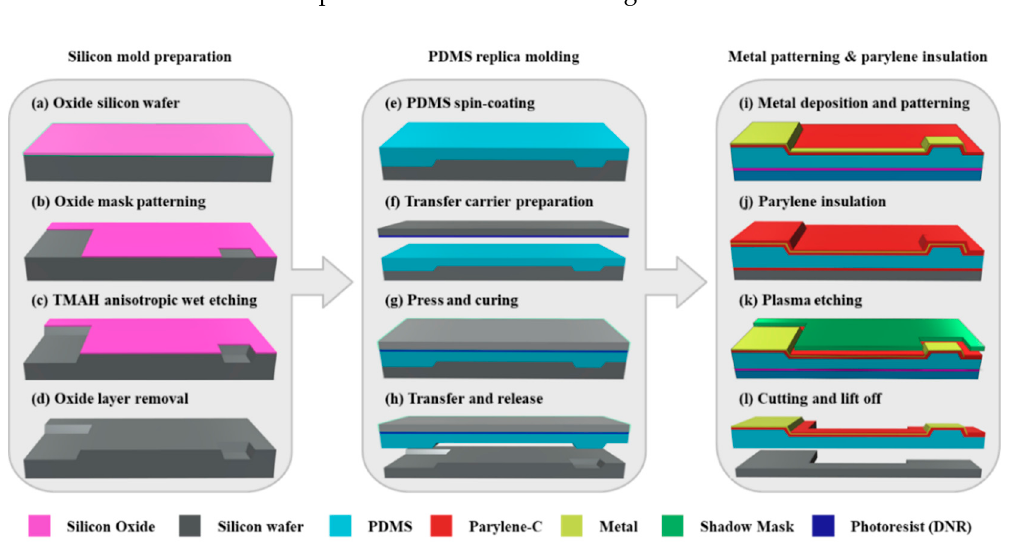
Figure 2. Schematic of the fabrication process flow for an MEA with replicated convex microstructures.